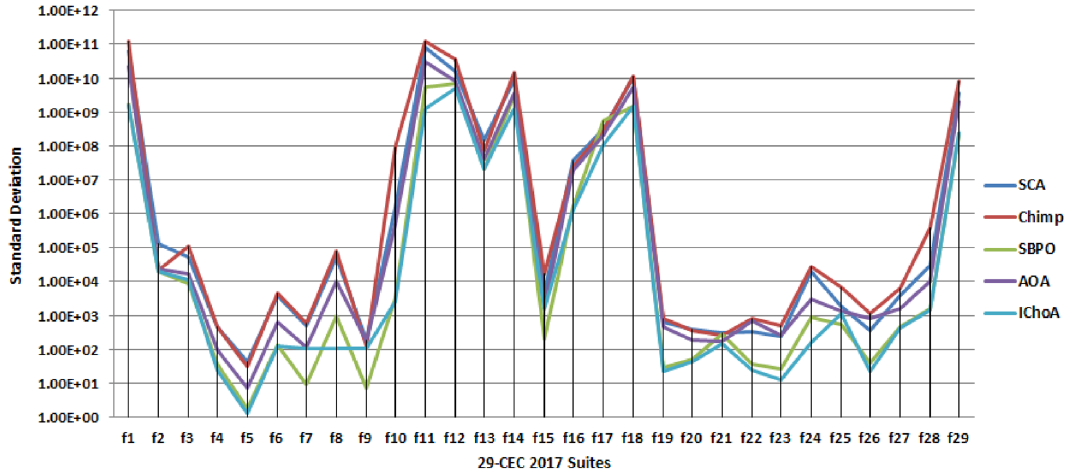
Figure 2. Statistical best ( sd ) solutions graph of algorithms on the 29-CEC’2017